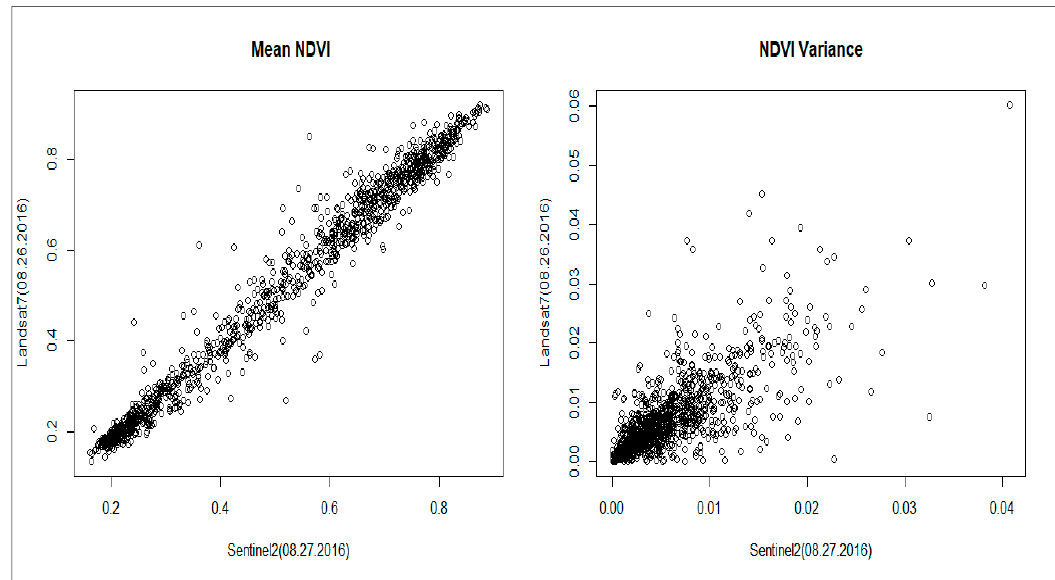
Figure A1. Comparison of NDVI values between two closely taken images from Landsat 7 and Landsat 8 satellites, indicating comparably similar distribution and statistics.